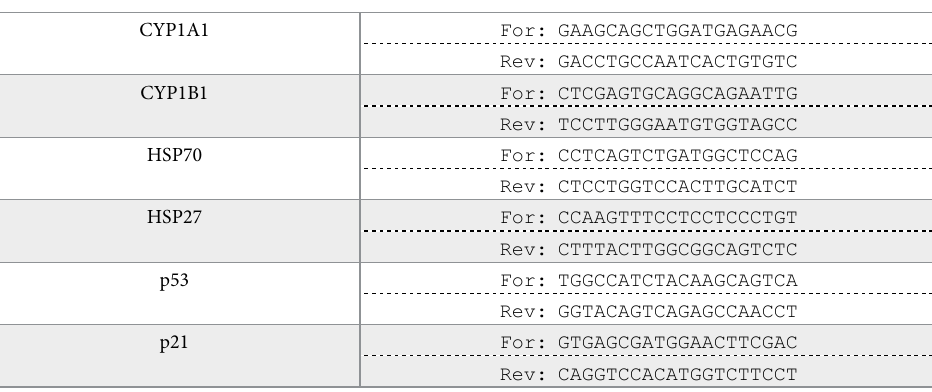
-PDPA analyzed in DI water + 0.25% (v/v) TFA. 25 67 -PDPA in CDCl /CD OD 3:1 25 67 3 3